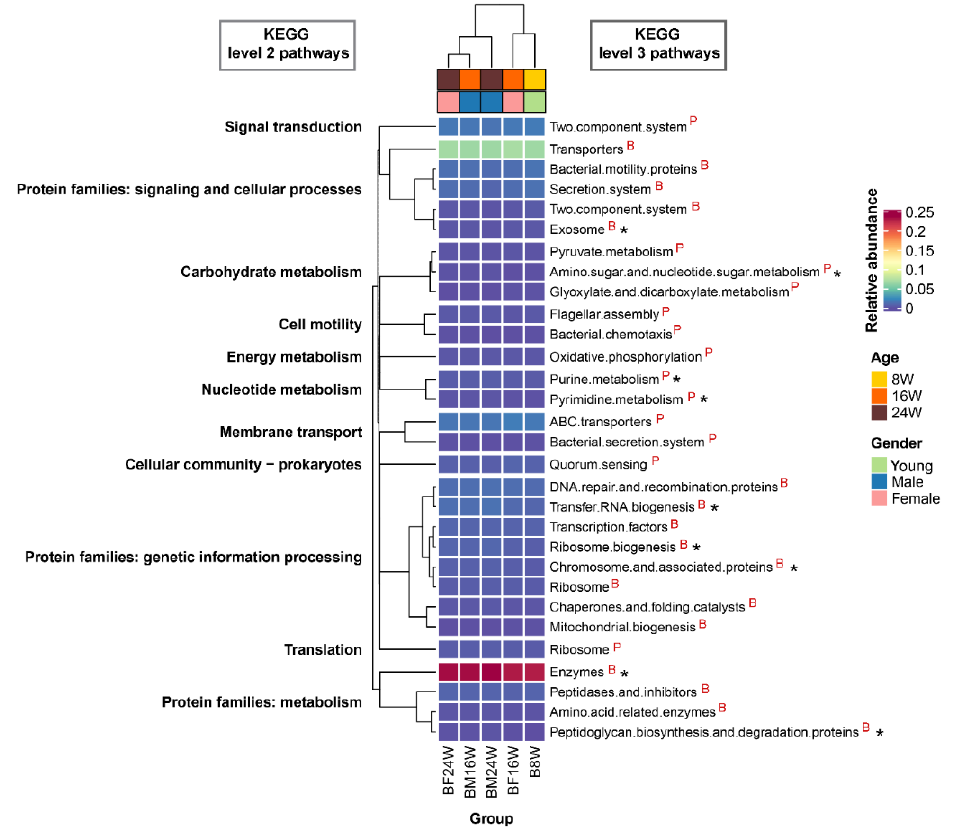
Figure 6. Hierarchical clustering of predicted Siamese fighting fish gut microbiota function across age and gender groups based on Bray-Curtis dissimilarities. The heatmap represents the relative abundances of microbial gene functions identified at the KEGG level 3 pathway. Rows are split according to identified KEGG level 2 pathways. It should be noted that heatmap construction excluded 1047 KEGG genes related to orthologs, modules, and networks that were not included in ‘Pathway or Brite.’ An asterisk (*) indicates significant differences across groups ( p < 0.05). Top annotations refer to the age and gender of Siamese fighting fish. KEGG database classification: P, Pathway maps; B, Brite hierarchies and tables. B8W, 8-week-old Siamese fighting fish;